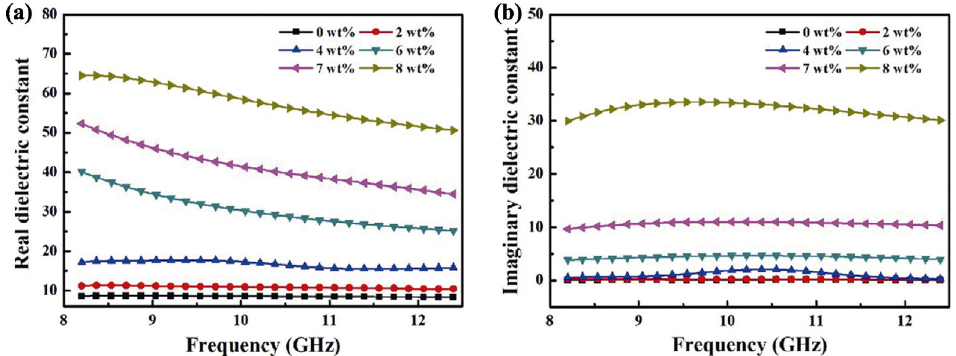
Fig. 13 Dielectric constants of SG/AlN composites with different SG